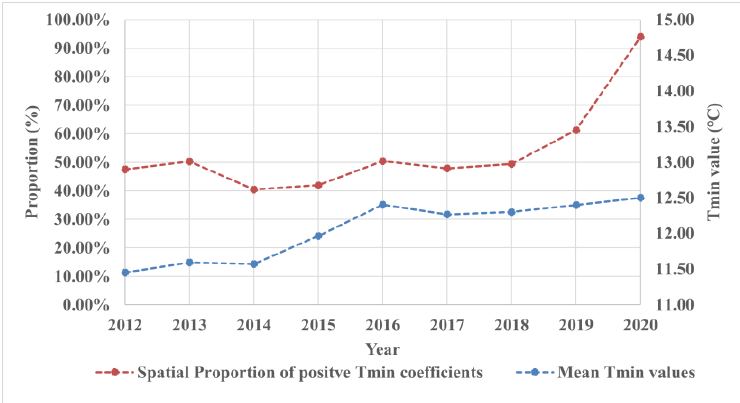
Figure 18. Temporal trends of mean Tmin values and spatial proportion of positive Tmin coeffi- cients.